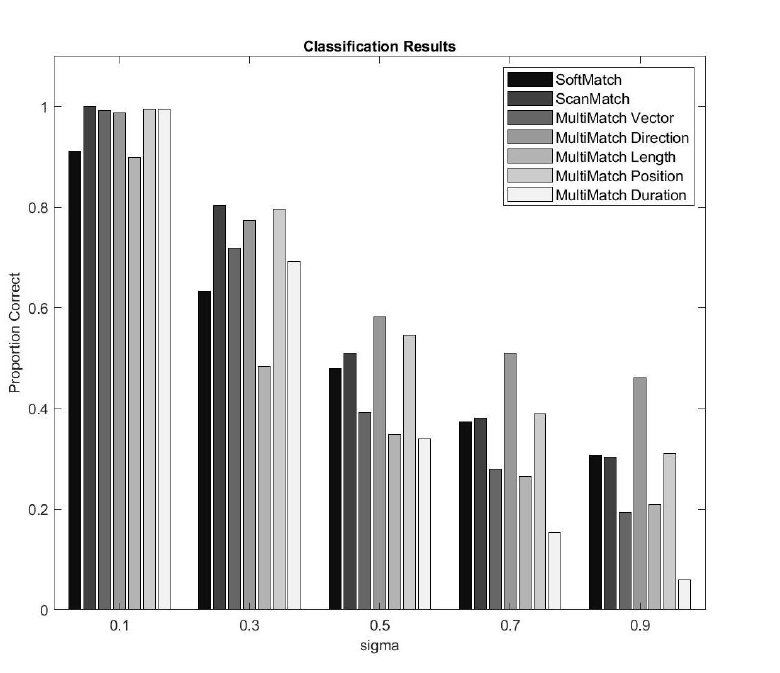
Figure 10. Twenty-four unique, random scanpath adversaries. S1, S2 including S1p, which is a noise perturbed version of S1. The levels of ( σ ) represent S1p perturbation as a measure of percentage of screen width and milliseconds between 150 and 300 ms. Each set was perturbed 50 times for a total of 6000